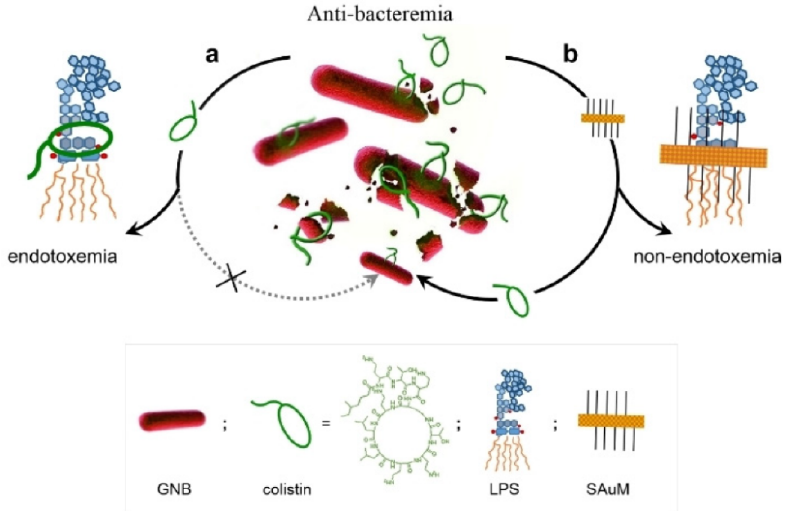
Figure 4. A Supramolecular Trap to Increase the Antibacterial Activity of Colistin. In Path a, free LPS can block the function of colistin. And the free LPS can be sequestered by SAuM in the circulat- ing blood (in Path b), thus promoting the killing efficiency of colistin against GNB while also minimizing endotoxemia. Reprinted with permission from Ref. [60]. Copyright 2020,